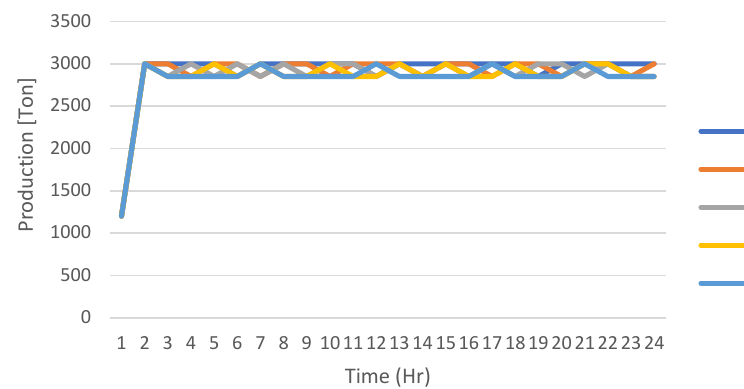
Figure A1. Case study evaluated with high frequency.